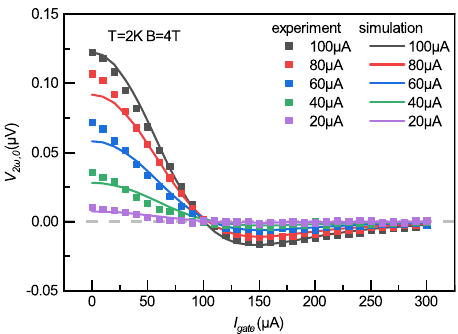
Fig. 4 Gate tuning of a MnPS 3 magnon valve with different I in : simulation and experiments. Simulation of gate-dependent V 2 ω ,0 at 2 K and 4 T with fi ve selected injection current I in . Only three global parameters are needed to produce all the simulation curves which match well with the experimental